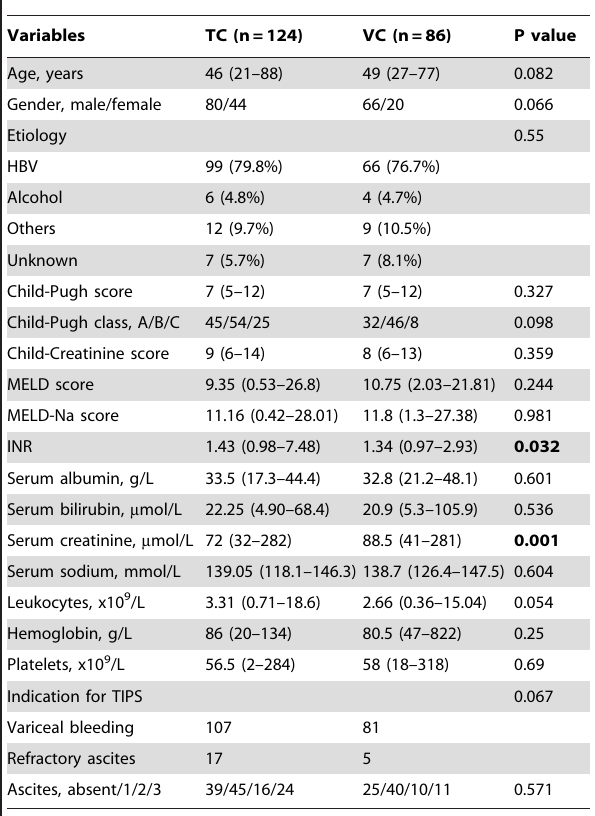
Table 1. Demographic, clinical, and biochemical characteristics of cirrhotic patients with SPH who underwent TIPS with covered stents.